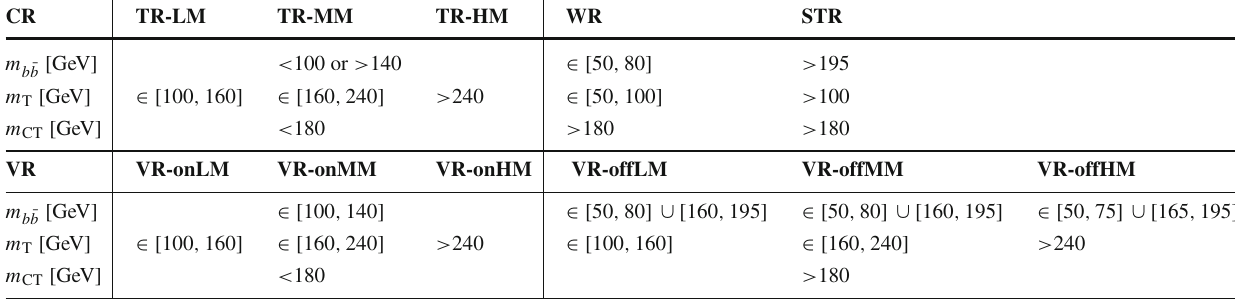
Table 3 Overview of the CR and VR definitions. All regions partially share the same selection as the SR for all variables except m ((cid:10), b 1 ) , which is not used in the CR and VR